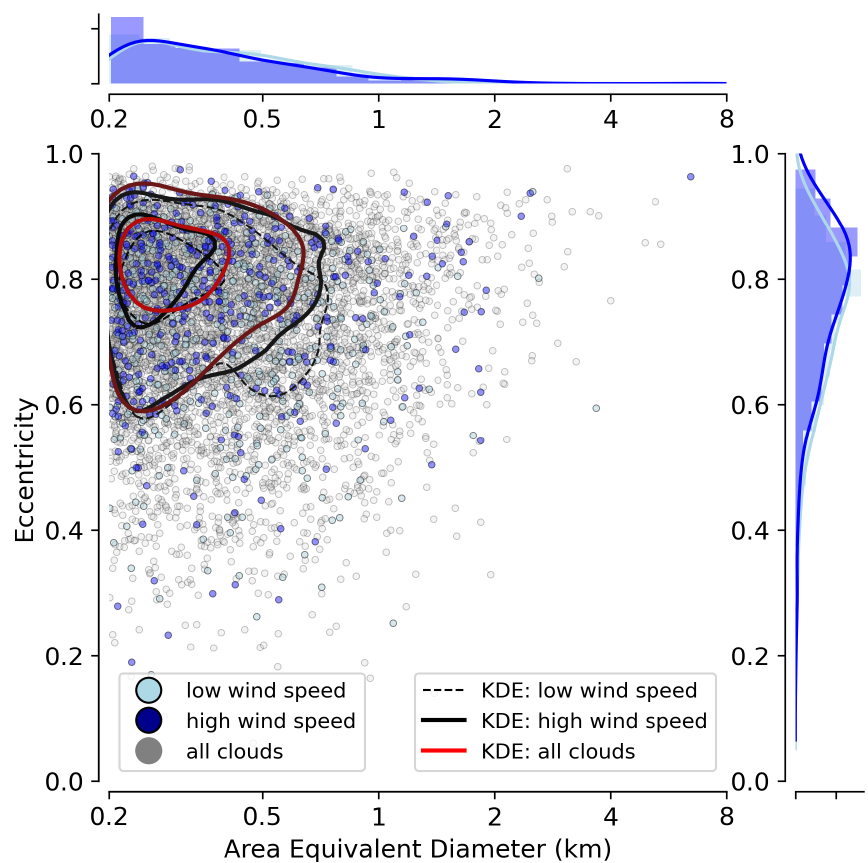
Figure 12. Joint frequency distribution of cloud size (referred to as the area-equivalent diameter) and eccentricity for clouds of RF03 and RF06, with L > 200m, and the cloud samples affected by low and high wind speeds. Contour lines representing three iso-proportions of the kernel density estimate (KDE) distributions for both quantities are also given separately (top and right).